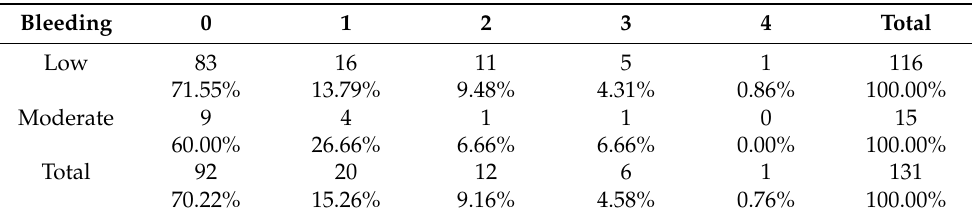
Table 21. The proportions of the PUUS values of patients regarding the postpartum bleeding. There was no patient with heavy bleeding. Most patients had a low level of bleeding, and only a few had moderate bleeding.